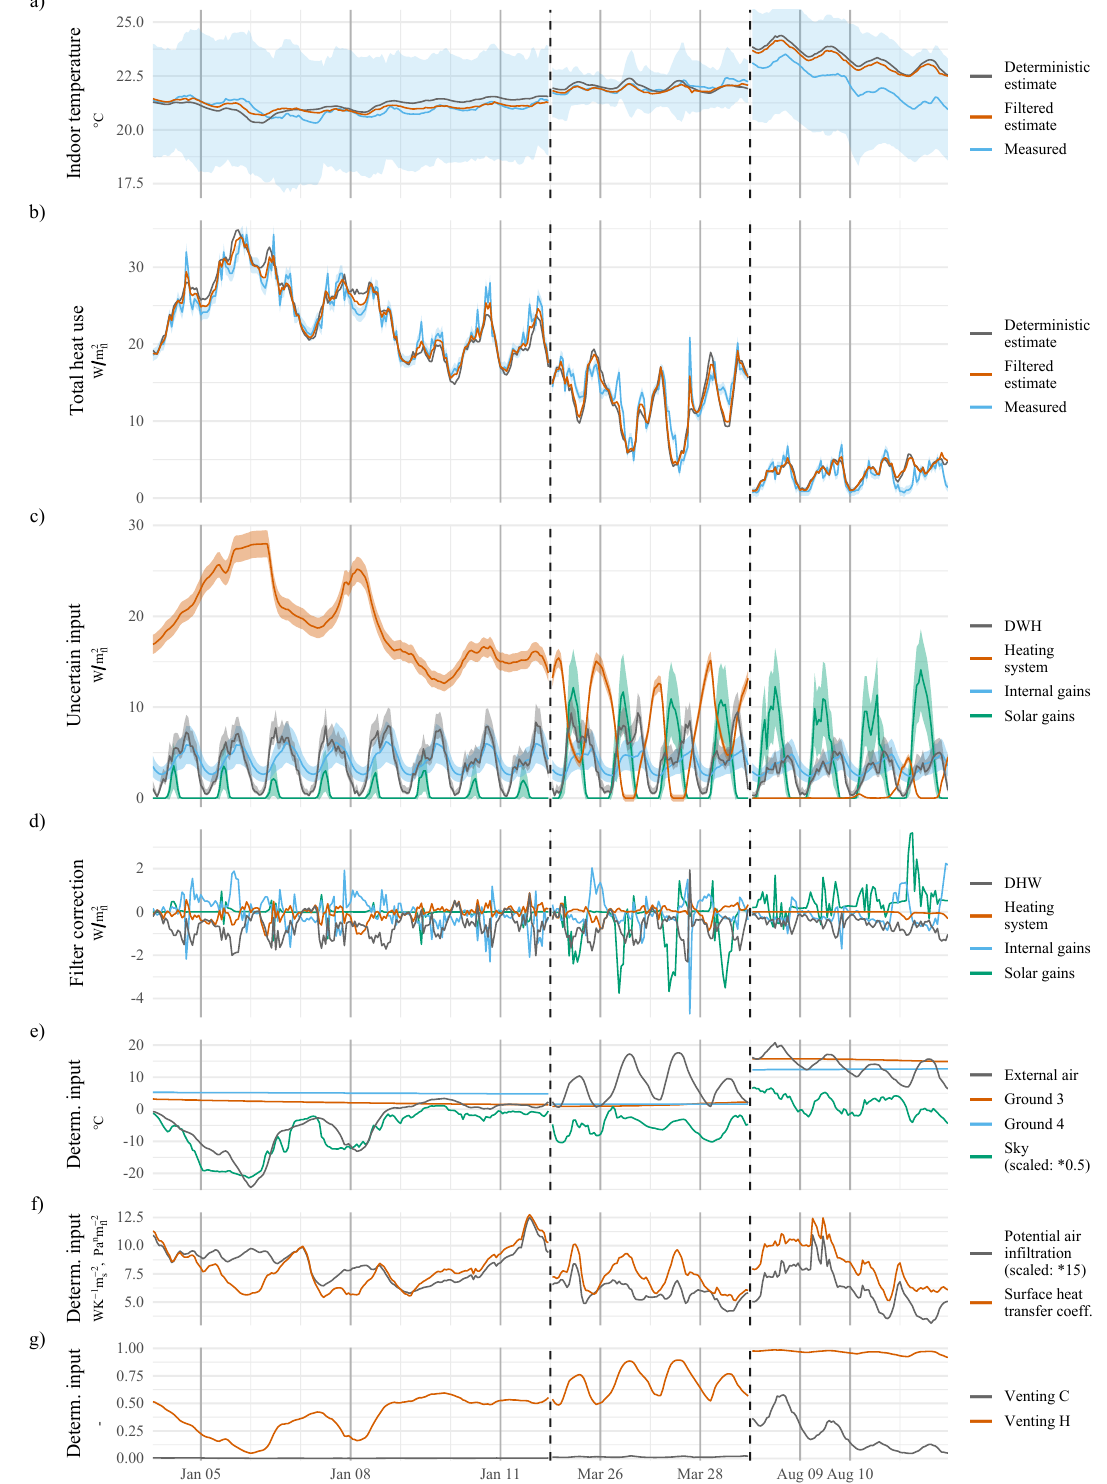
Figure 11. Hourly inputs and outputs of the Bayesian filtering simulation: ( a , b ) Comparison of measured values to both filtered and deterministic simulation outputs for indoor air temperature and total heat use; ( c ) normally scaled uncertain inputs; ( d ) normally scaled corrections (i.e., augmented states); ( e – g ) the deterministic inputs: 95% confidence interval is shown for the measured outputs and uncertain